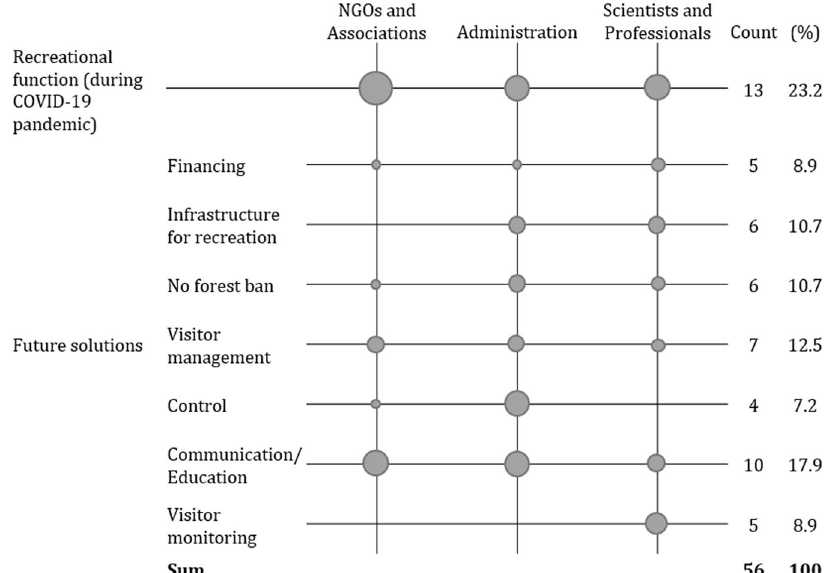
Fig. 3 The recreational function of CCF during the COVID-19 pandemic. Boxes represent the average quantity of segmented codes per interviewee per stakeholder